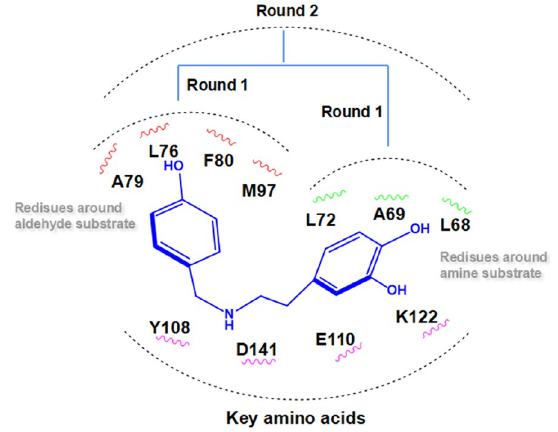
enzyme. Reactions were performed at 30 °C for 24